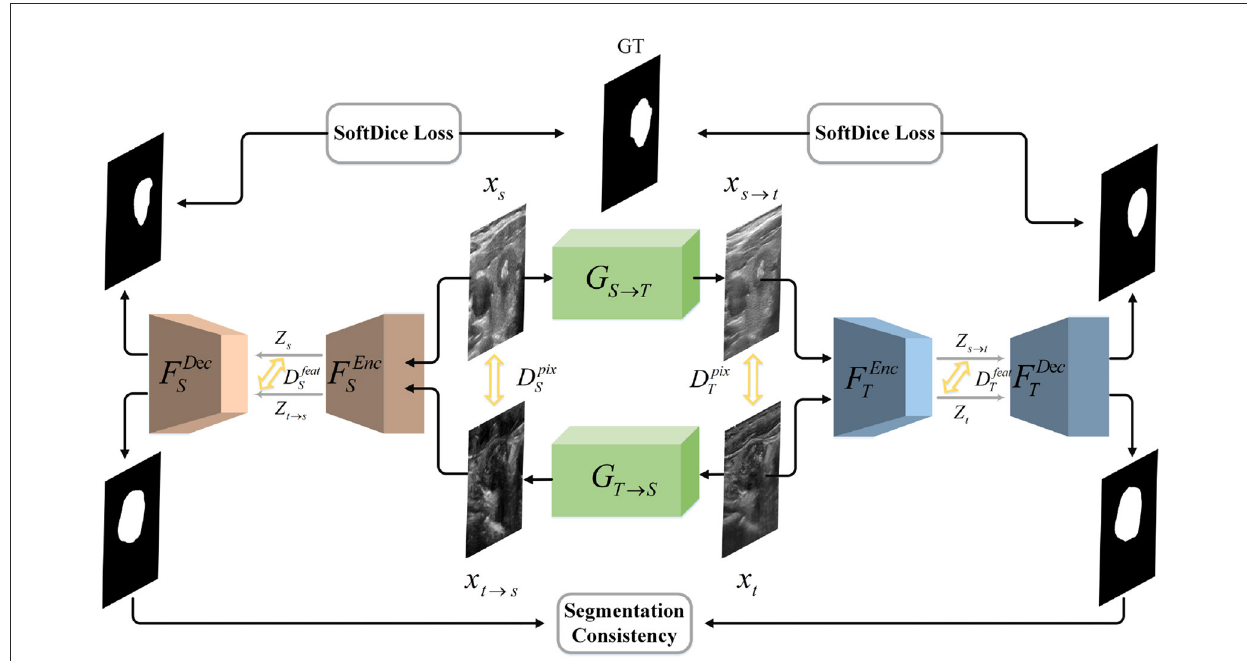
FIGURE1 Illustration of our network architecture. We design a bidirectional translation module to respectively generate x t → s and x s → t . We introduce adversarial loss to unify the style of translated and target domain on both the pixel and feature level. Then we utilize two symmetrical segmentation modules, i.e., F S and F T , to respectively achieve segmentation in two domains. SoftDice loss and segmentation consistency loss are proposed to further conduct the network.